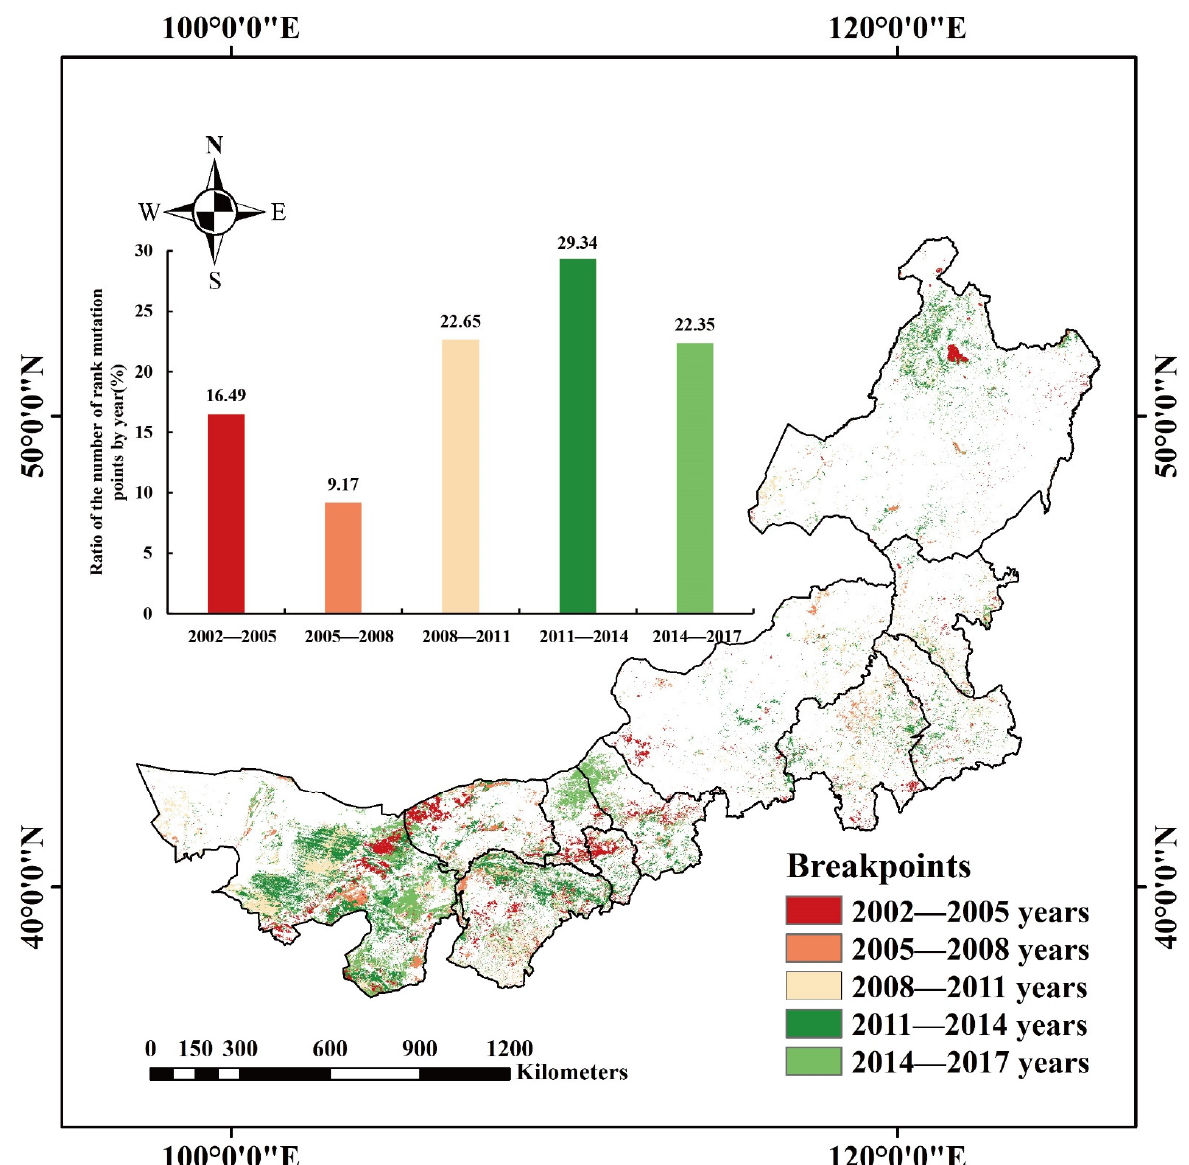
Figure 6. Spatial distribution for breakpoints years of NDVI in Inner Mongolia during 2000 – 2019.